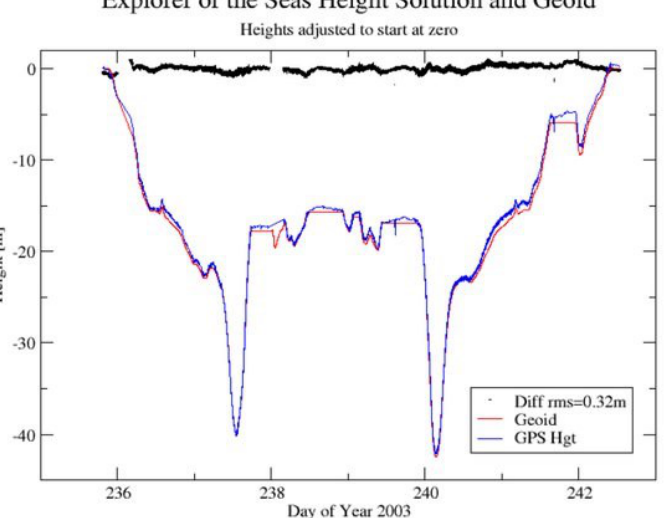
Figure 4. Height of the GPS antenna on the ship, corrected for ocean tides (blue) and the CARIB97 geoid (red). The RMS (root mean square) of the difference (thick black) is 0.32 m [4].